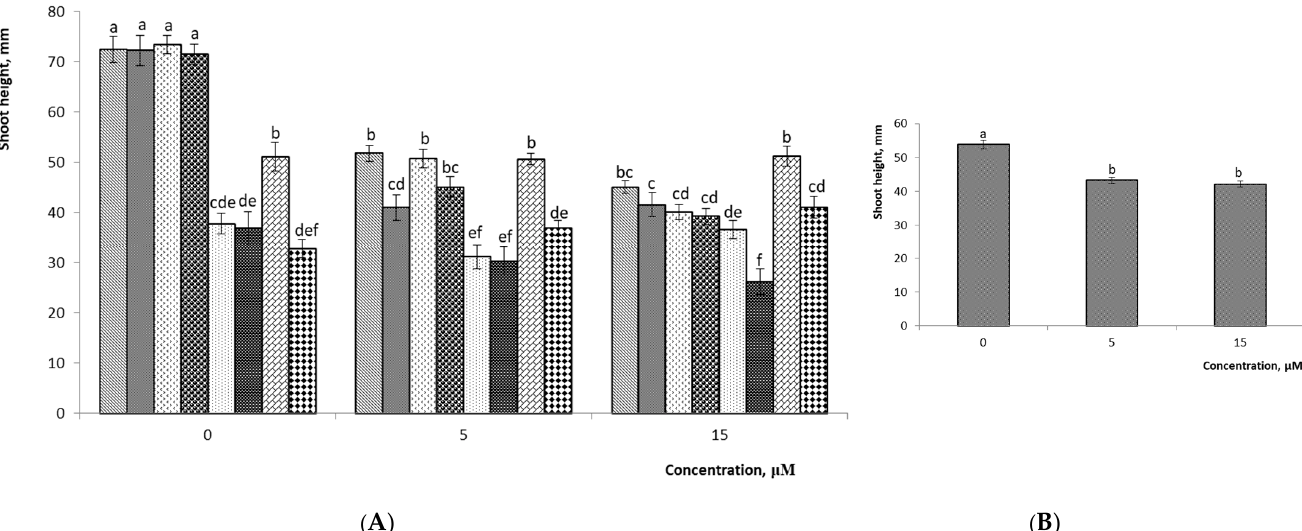
Figure 6. Effect of 2iP concentration on shoot height of V.ul. 8 × ‘NC’: ( A ) detailed analysis of values of hybrid variants; ( B ) average values of hybrid variants. Means followed by the same letter are not significantly different according to the LSD at p ≤ 0.05. Note: 1-1, 1-2, 1-5, 2-2, 4-2, 4-6, 4-8, 5-3—variant Nos. 1-1, 1-2, 1-5, 2-2, 4-2, 4-6, 4-8, 5-3.